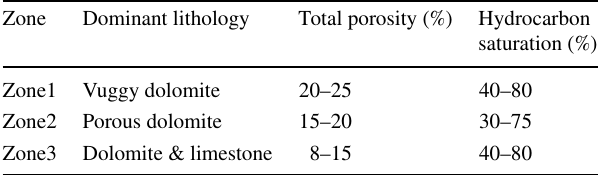
Table 1 Reservoir zonation and rock petro-physical properties